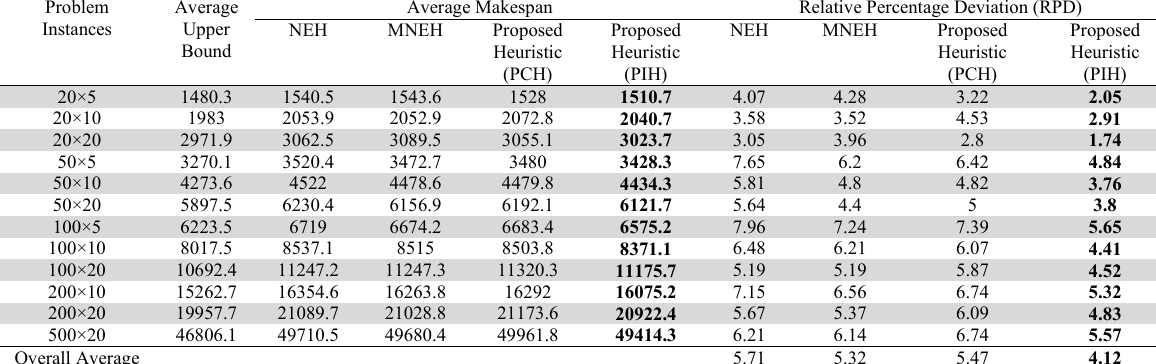
Relative Percentage Deviation on Taillard Instances Problem Average Instances Upper